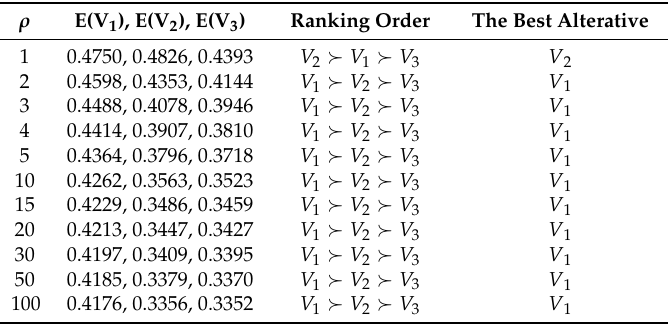
Table 4. Ranking orders of the LCVDWGA operator, ρ ∈ [1–5,10,15,20,30,50,100].